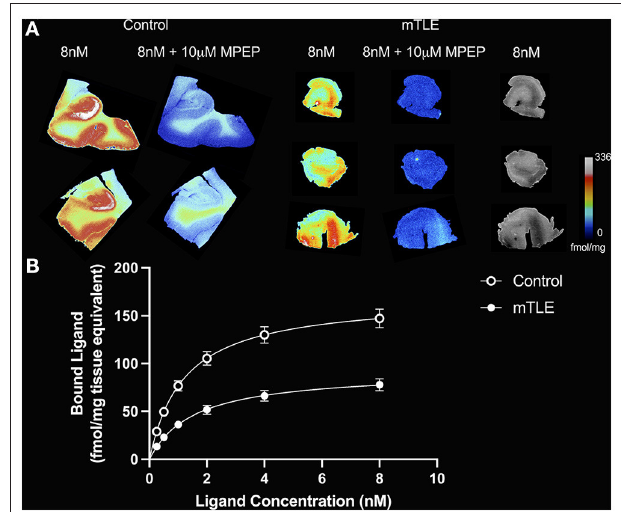
FIGURE 1 | [ 3 H]ABP688 binding in the hippocampus. (A) Saturation autoradiography with [ 3 H]ABP688 in the hippocampus of two non-epilepsy necropsy controls and three mesial temporal lobe epilepsy (mTLE) patients. 10 µ M of 2-Methyl-6-(phenylethynyl)pyridine (MPEP) was used to assess non-specific binding. Greyscale images with 8nM [ 3 H]ABP688 demonstrate hippocampal structure in resected tissue from mTLE patients. (B) Autoradiographic saturation binding curves constructed from total and non-specific binding data. Displayed are the mean curves for specific binding of mGluR5 by [ 3 H]ABP688 in hippocampal specimens from mTLE patients and non-epilepsy controls. Error bars represent SEM.